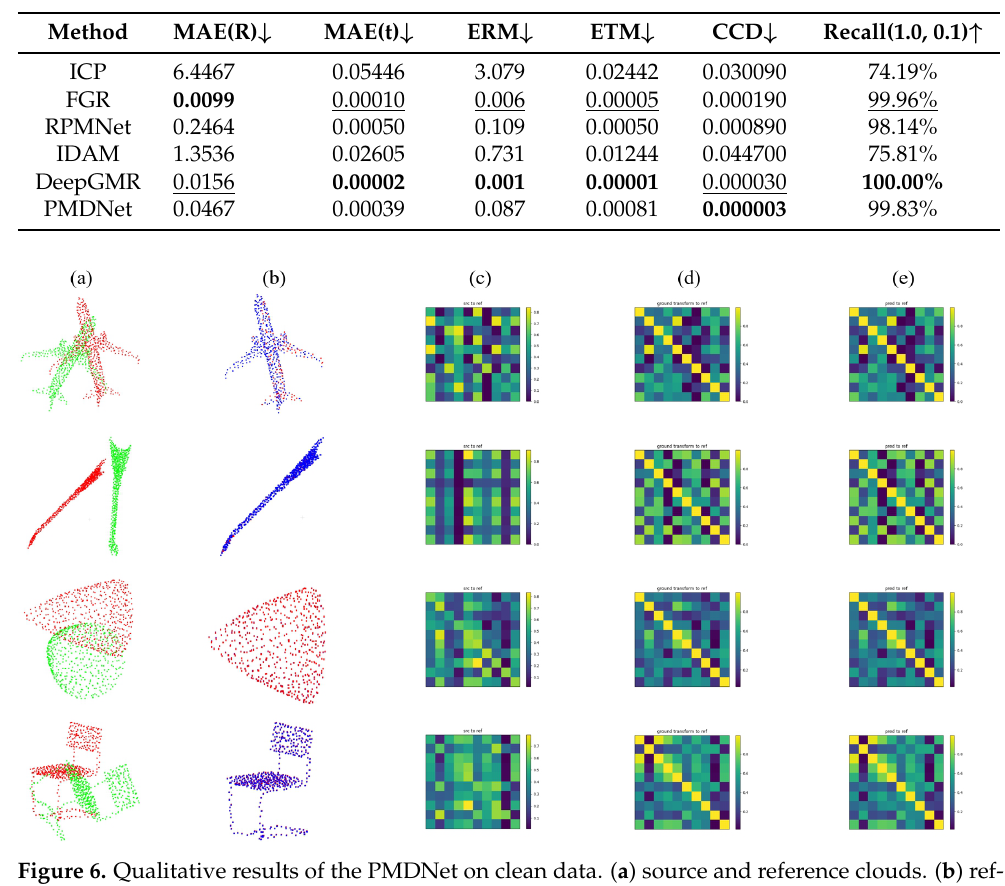
Table 5. Results on clean data. Bold and underline denote best and second best performance.